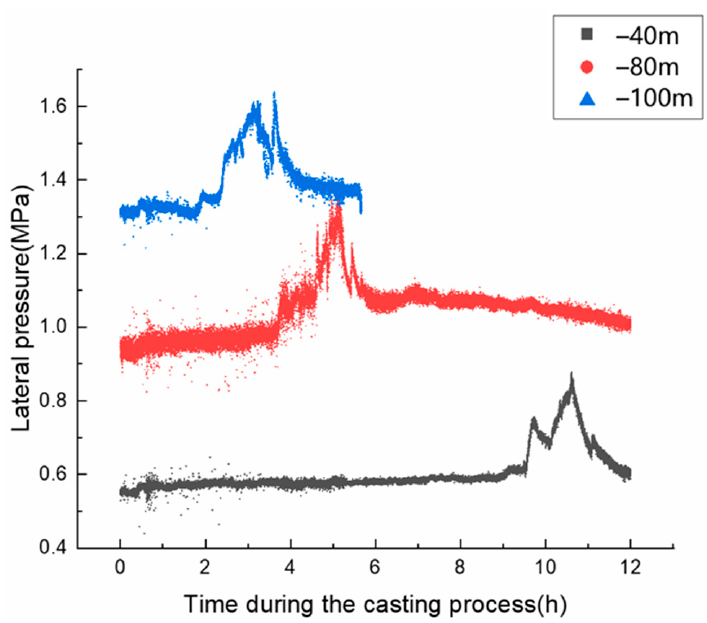
Figure 3. Development of lateral pressure during the filling process.